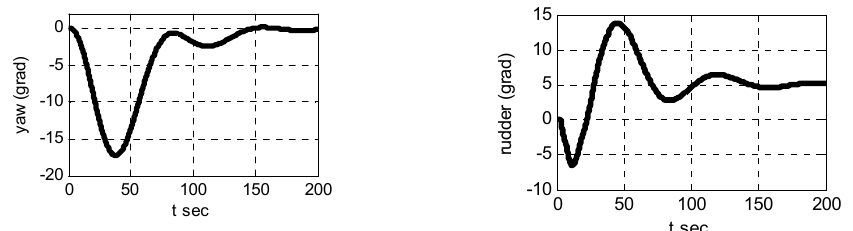
Figure 8. Graphs of the functions y ( t ) and δ ( t ) for real closed-loop system (23), (30), (31) in Regime 2 of motion.